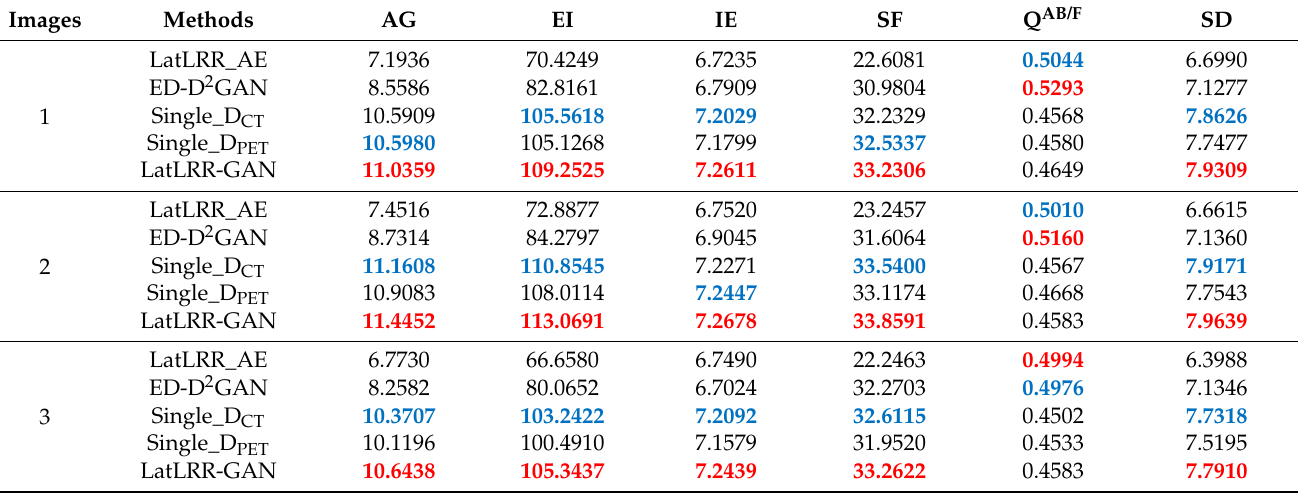
Figure 8. The evaluation metrics coefficient radar maps of CT lung window images and PET images about the ablation experiments. Method 1: LatLRR_AE; Method 2: ED-D 2 GAN; Method 3: Sin- gle_D CT ; Method 4: Single_D PET ; Method 5: LatLRR-GAN. Table 3. The fused images’ evaluation metric results of CT lung window images and PET images